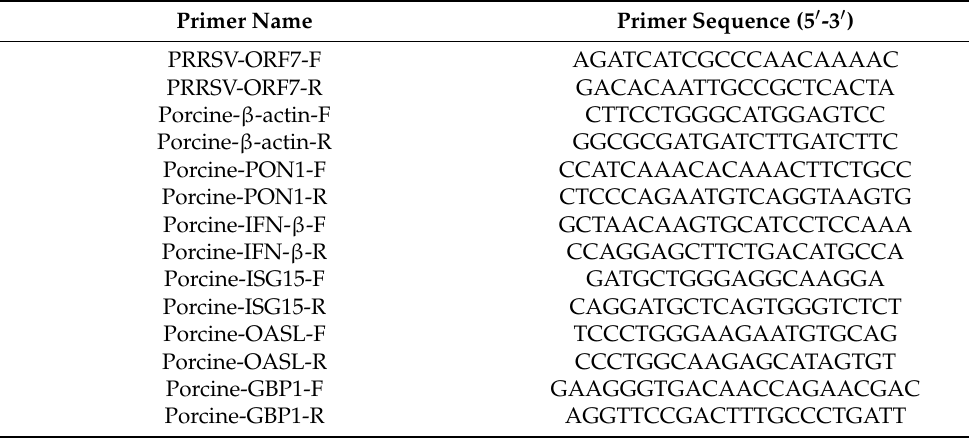
Table 3. Primers used for relative quantitative